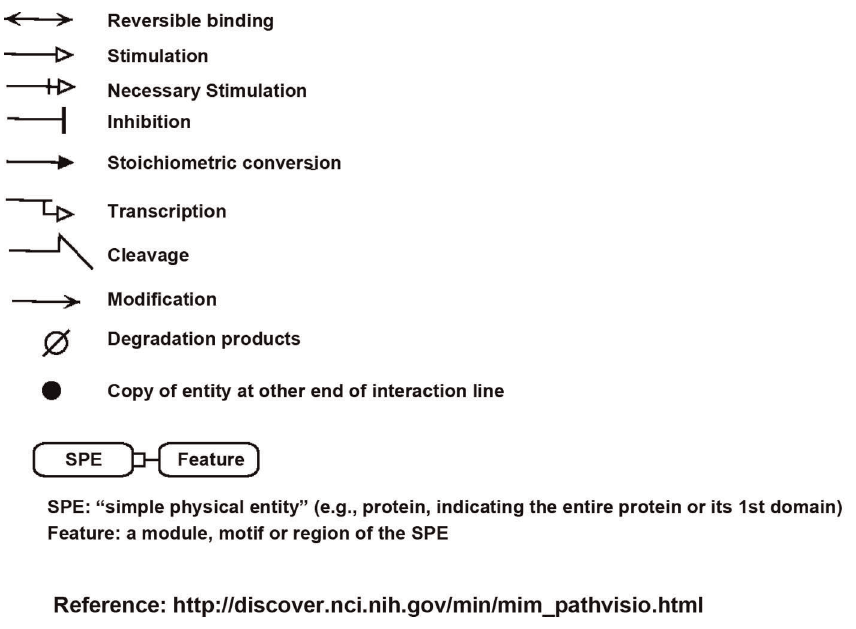
Figure 9. Essential molecular interaction map (MIM) symbols. For detailed descriptions of the MIM notation, see [13] or http://discover.nci. nih.gov/mim/mim_pathvisio.html